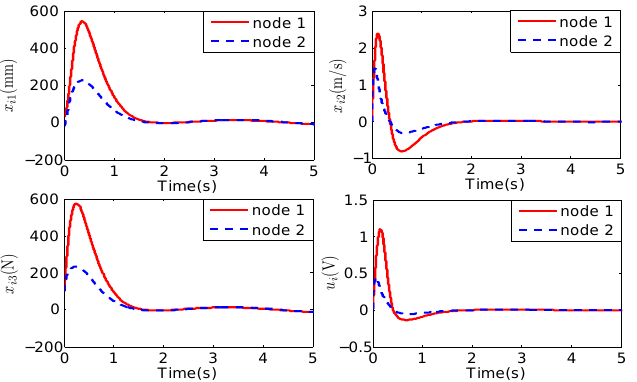
Figure 3. The MEHAs’ state responses of the two nodes in the simulation: x i 1 —the cylinder position; x i 2 —the cylinder velocity; x i 3 —the cylinder load pressure; u i —the control voltage of the servo valve.